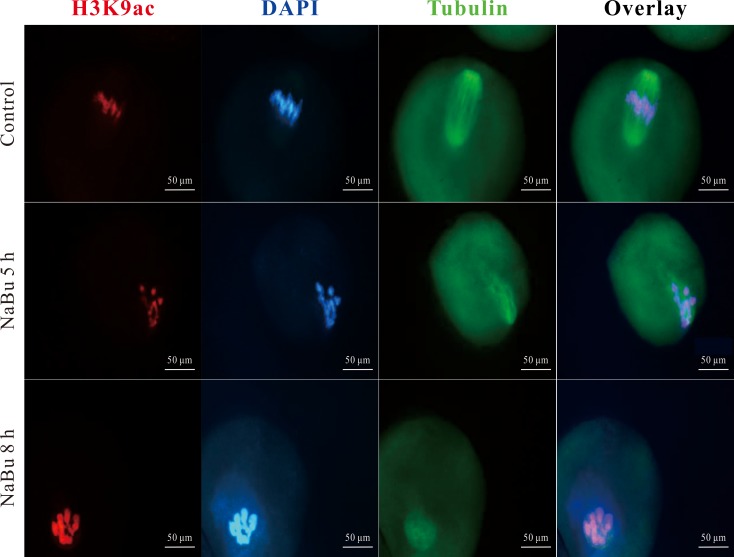
Effects of NaBu treatment on the spindle apparatus of MI stage oocytes.Mouse GV stage oocytes were obtained and randomized into three groups as described in experiment 2. After 8 h of culture, the oocytes were immunostained with anti-acetyl-histone H3K9 (red) and anti-α-tubulin (green) antibodies. The DNA of these oocytes was counterstained with DAPI (blue). Scale bar: 50 μM.